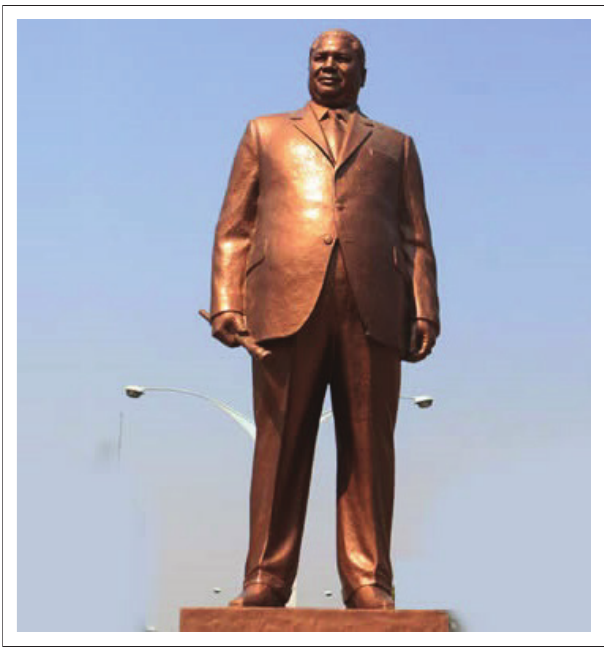
FIGURE 5: Dr Joshua Nyongolo Mqabuko Nkomo, North Korea.